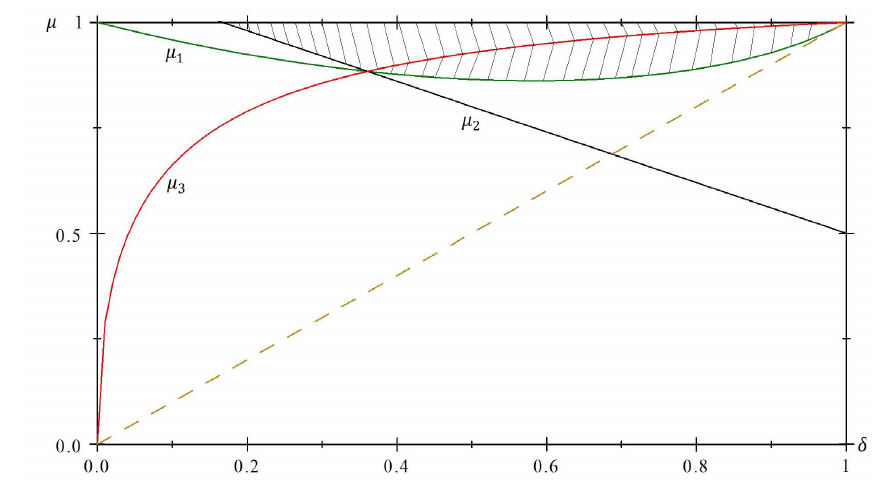
Figure 1. Pairs ( δ , µ ) yielding multiple SPE expected outcomes when n = 11 and n B =